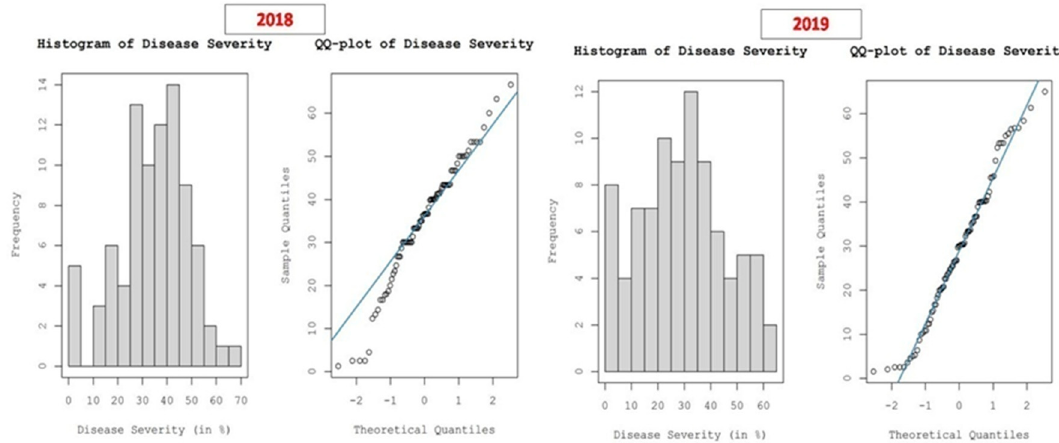
Figure 8. Histograms and normal QQ plots of FRD percent severity data used to understand the distribution of the dataset. The spatial distributions based on the FRD percent severity across the investigated areas in Karnataka varied greatly from year to year and location to location during the 2018 and 2019. The highest FRD percent severity were observed in parts of the Malnad areas (traditional areas of Shimoga, Chickmagalur, and North Canara districts) as com- pared to non-traditional arecanut growing districts (parts of Davanagere, Shimoga, and Chickmagalur), which showed relatively lower proportions of FRD occurrence (Figure 9). As with the IDW interpolation technique, OK was used to explore spatial patterns of FRD on arecanut plantations by considering percent disease severity observations ( n = 83). Or- dinary kriged surface maps for 2018 and 2019 revealed that the maximum FRD severity rates were observed in certain parts of Shimoga, Chickmagalur, and North Canara, fol- lowed by arecanut plantations located near the seashore and in humid tracts (Udupi and South Canara). In the ordinary kriged maps for 2018 and 2019, about 8.30% and 5.65%, respectively, of the total interpolated surface area was predicted to show higher FRD se- verity, which even exceeded 50% disease prevalence in some areas. Figure 9. Interpolated maps representing distribution patterns of FRD in Karnataka during 2018 and 2019 using employing ordinary kriging (OK). Red to green color-coded surfaces depicts higher to lower FRD percent severity rates.